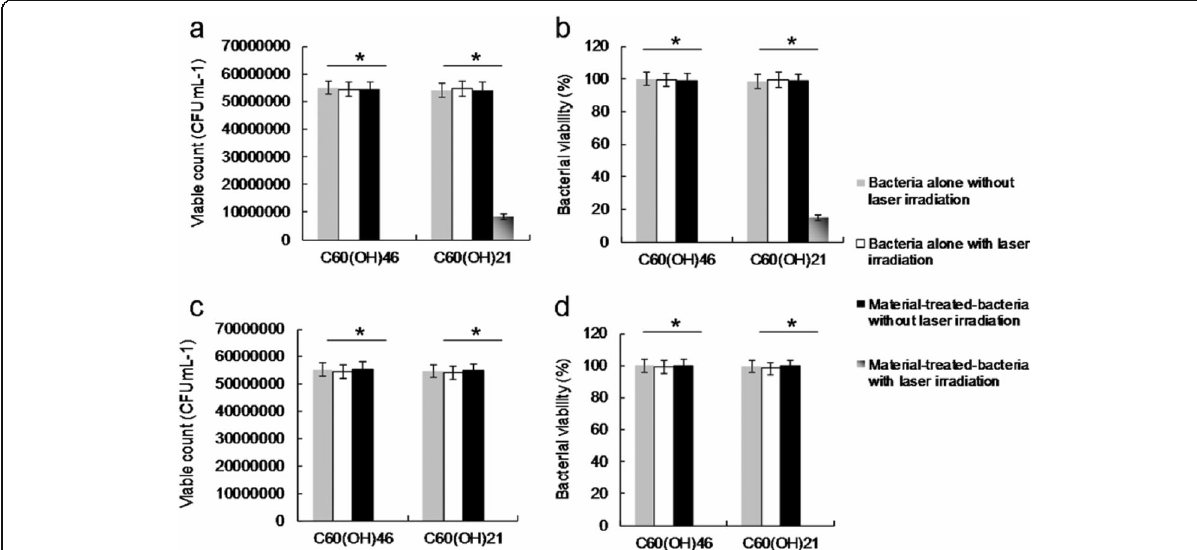
Fig. 4 Viability (%) was quantified according to the determined viable count of material-treated bacteria through a CFU assay conducted using short excitation with a TPE power of 211.2 nJ pixel − 1 with 800 scans (approximately 3.2621 s of total effective exposure time; Ex, 760 nm) to deliver a dose of a , b 3 or c , d 6 μ g mL − 1 . Delivered dose, OD600 0.05 of E. coli . Data are presented as means ± SD ( n = 6). For C 60 (OH) 46 - and C 60 (OH) 21 -treated E. coli with photoexcitation, a p < 0.001 and p = 0.662, b p < 0.001 and p = 0.658, c p < 0.001 and p < 0.001, and d p < 0.001 and p < 0.001. * p value obtained by Student ’ s t